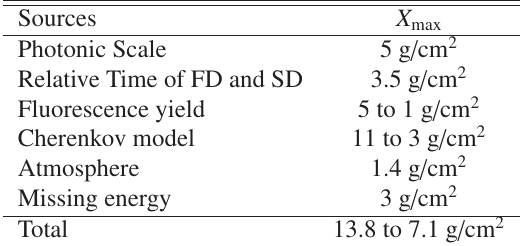
Figure 4: Top: (cid:6) X max (cid:7) as a function of shower energy, mea- sured by using 4 years of the TALE hybrid data. Bottom: σ ( X max ) as a function of shower energy. For both panel, the proton and iron MC rails are also shown.